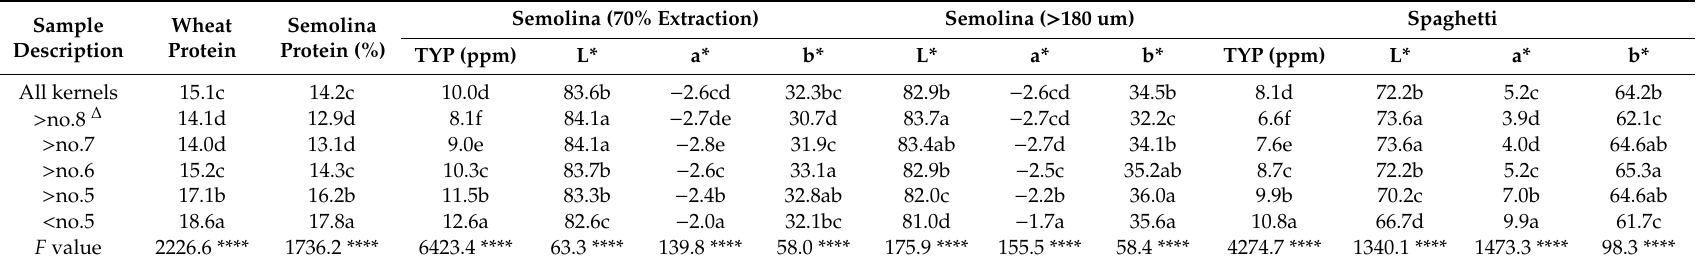
Table 4. Semolina and spaghetti color characteristics of durum wheat samples prepared based on kernel